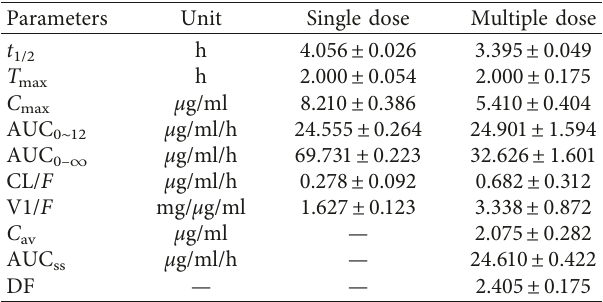
Table 5: Pharmacokinetics parameters of total components (mean ± RSD, n �